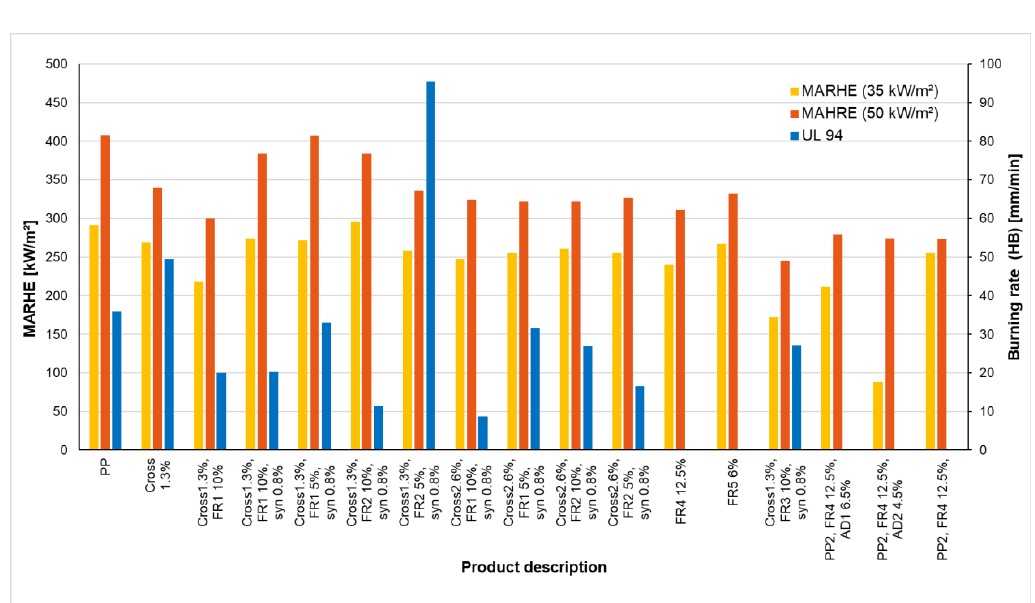
Figure 21. Fire properties of PP with various additives determined with irradiation (result MARHE) and with (horizontal) burning rate (UL94 HB).